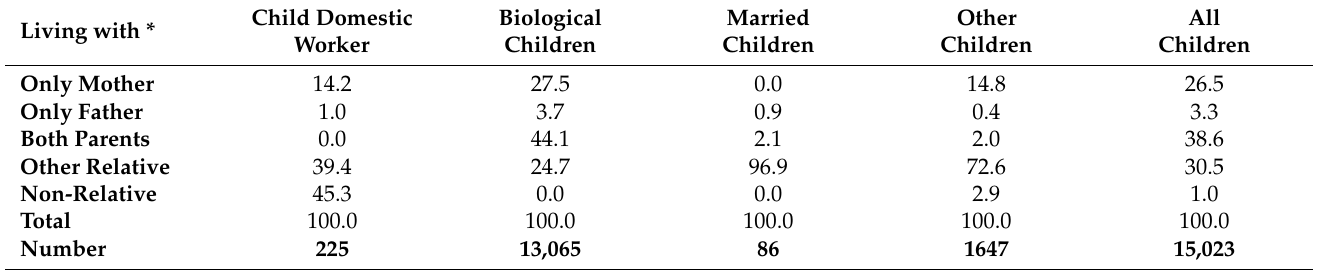
Table 2. Living Arrangements of Child Domestic Workers, Biological children, Married children, and other children in households in Zimbabwe, 2019 ( N =